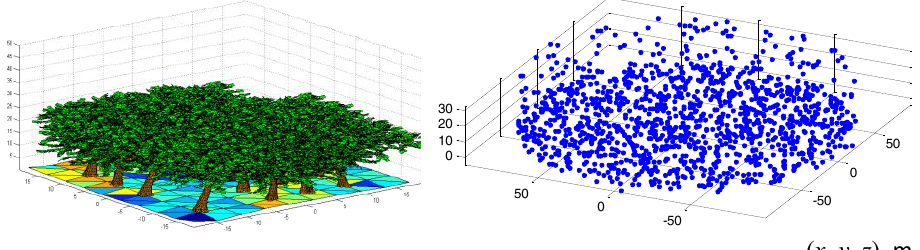
Fig. 6. Complex model and simplified facet field for modeling forest